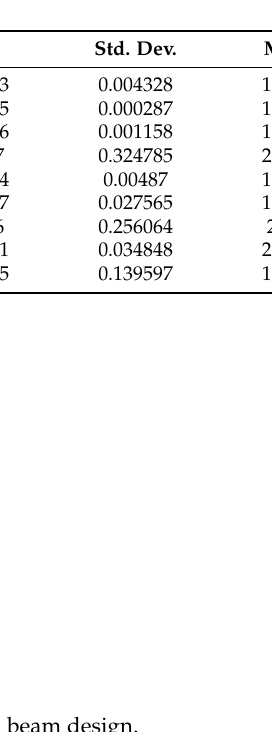
25 of 30 Table 13. Comparison results for welded beam design problem. Algorithm